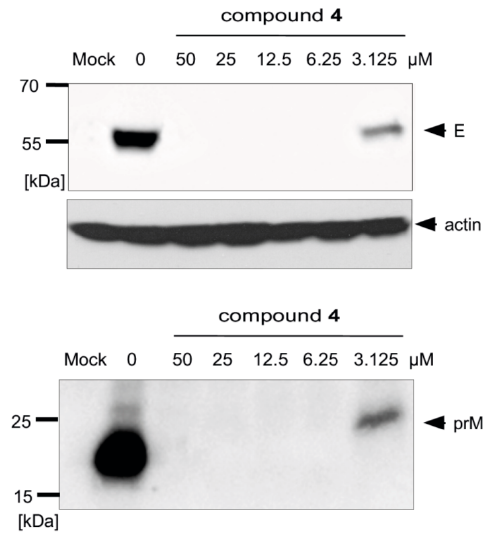
Figure 7. Effect of compound 4 on glycoprotein E and prM protein synthesis. A549 cells were infected with the TBEV Neudoerfl strain at an MOI of 0.1 and treated with different concentrations of the compound. At 48 h p.i., cells were lysed and proteins were separated by SDS-PAGE (gradient 10–20% polyacrylamide) under non-reducing conditions. Western blot analysis was performed using the monoclonal anti-Flavivirus group antigen antibody (4G2) for the detection of glycoprotein E, rabbit monospecific polyclonal serum for pr fragment detection, and anti-actin monoclonal antibody.